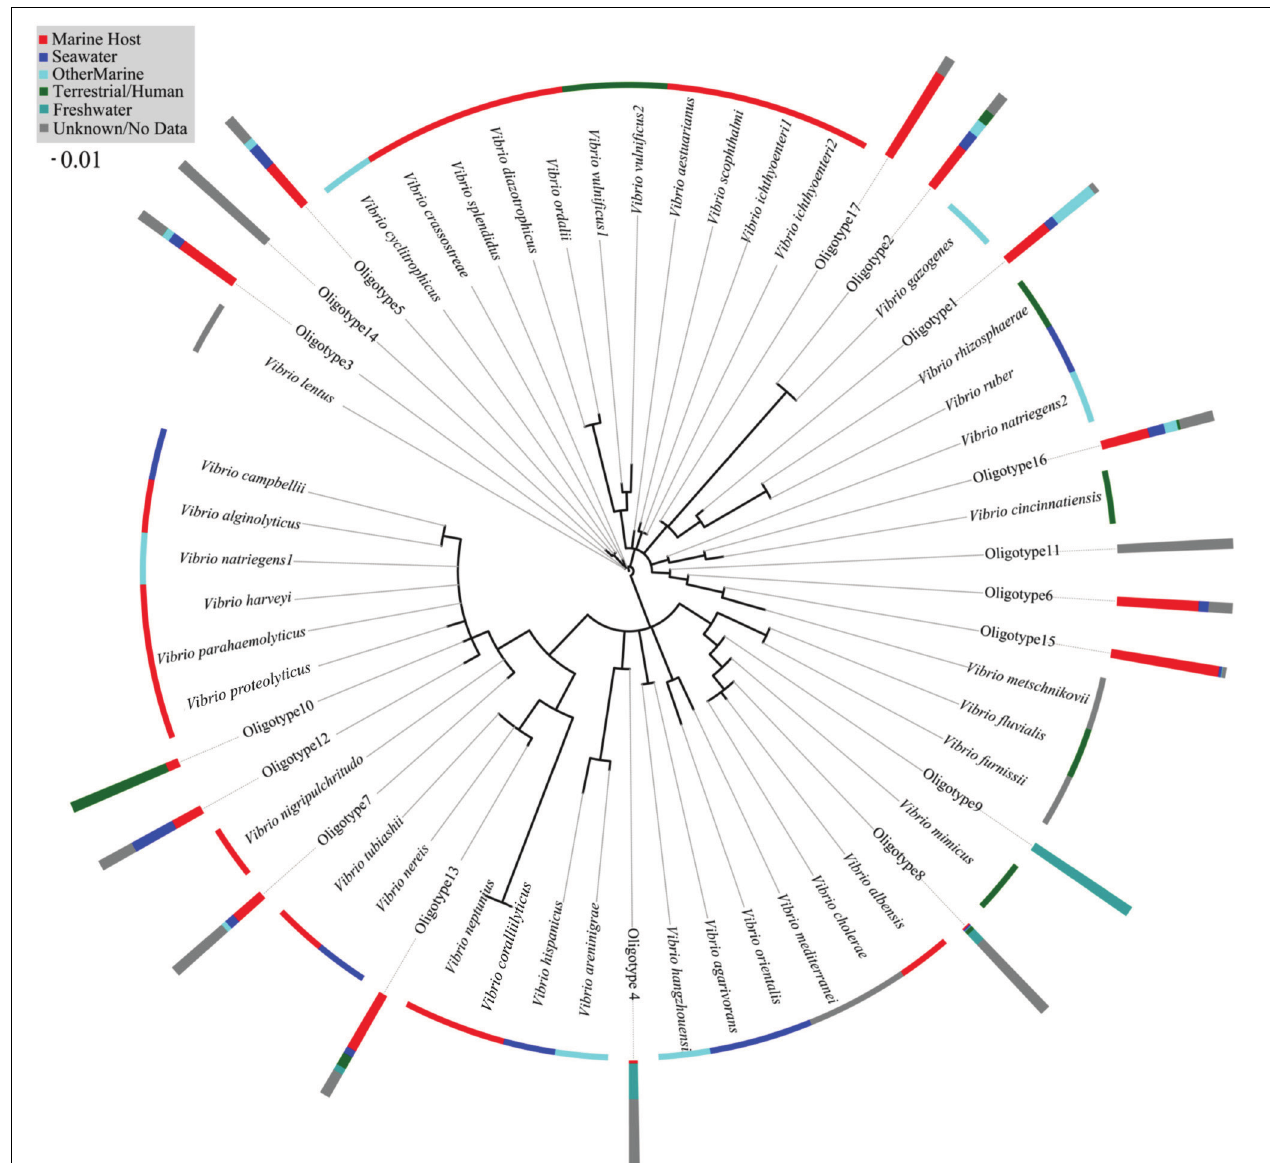
FIGURE 7 | PhyML phylogeny of full-length 16S rRNA gene sequences from type strain isolates in the SILVA ARB database, with the 17 most abundant oligotypes found in this study added by Maximum Parsimony over the 60bp region. The isolation source for each type